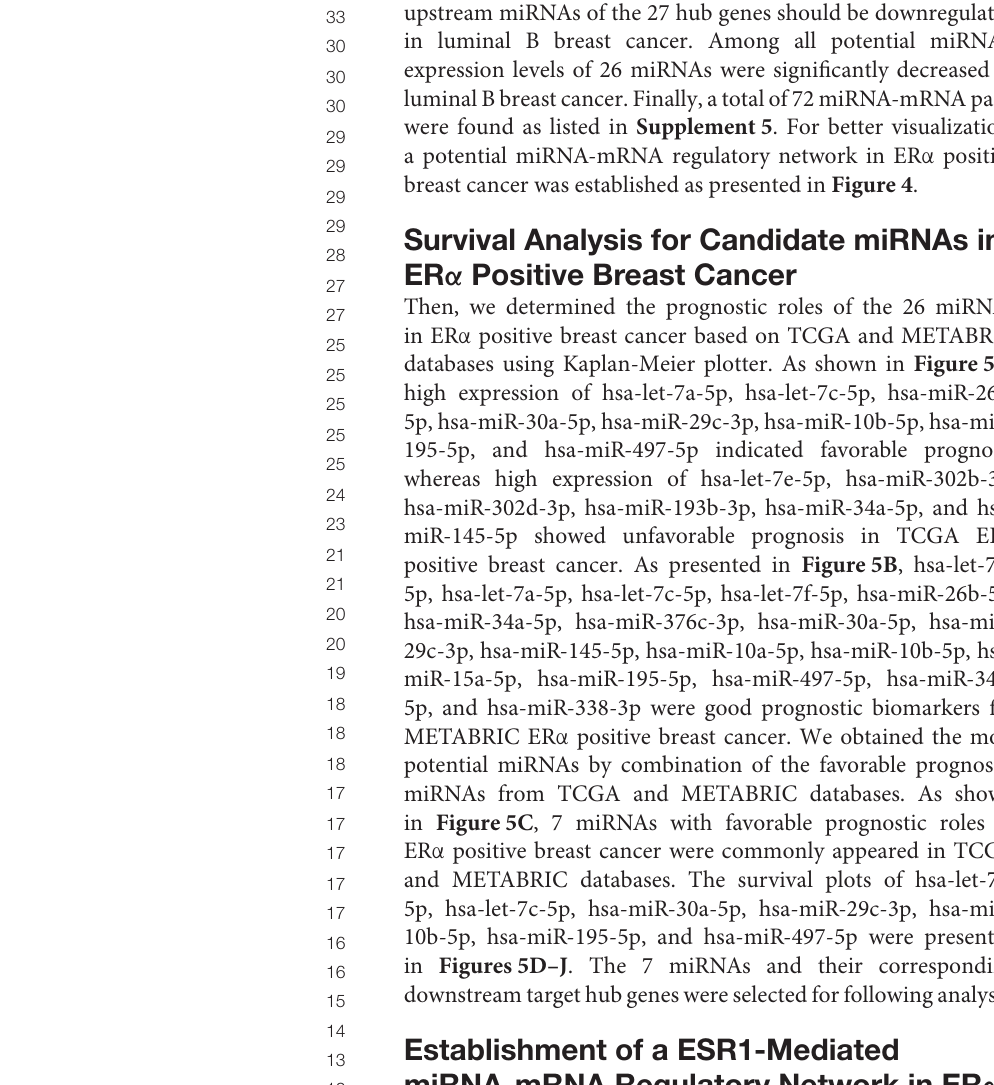
( Figure 6F ), and hsa-miR-497-5p ( Figure 6G ) in ER α positive breast cancer. In the next step, we wanted to ascertain if